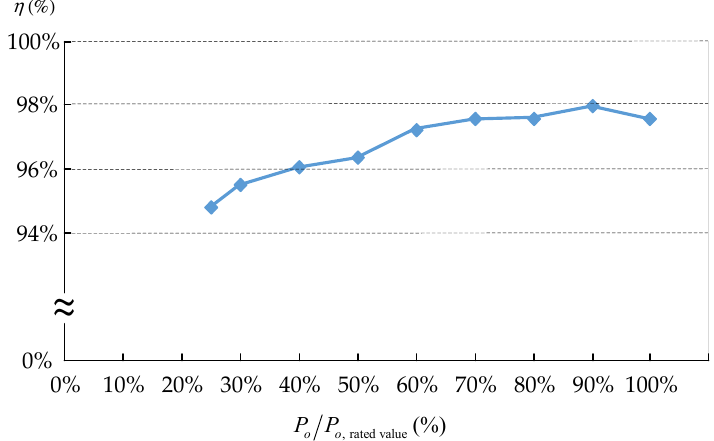
Figure 12. Measured circuit efficiency at different output power levels.